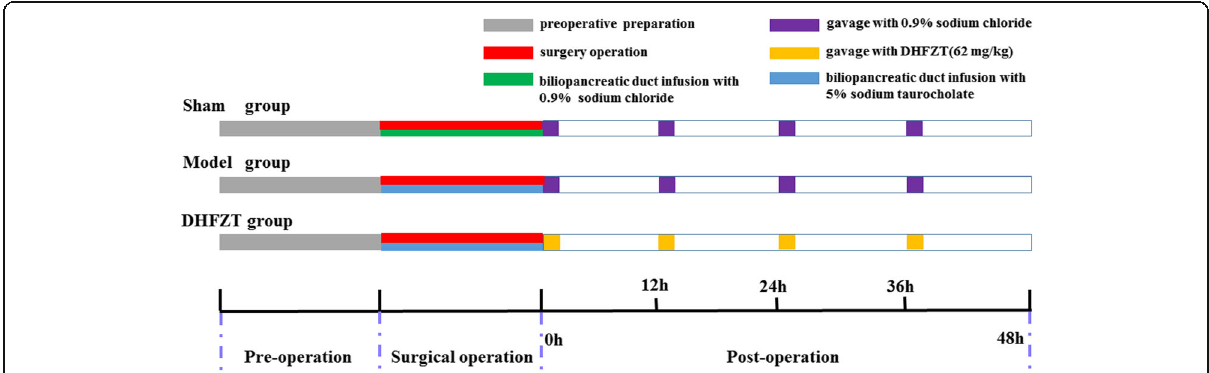
Fig. 1 Experimental protocols. All Rats were subjected to surgery operation in sham group, model group and DHFZT group. 5% sodium taurocholate (0.1 ml/100 g) was injected retrogradely into biliopancreatic duct to induce SAP model in rats. 62 mg/kg of DHFZT extract dissolved in 2 ml of 0.9% normal saline was administered to DHFZT group rat at 0, 12, 24, 36 h post-operation. DHFZT: